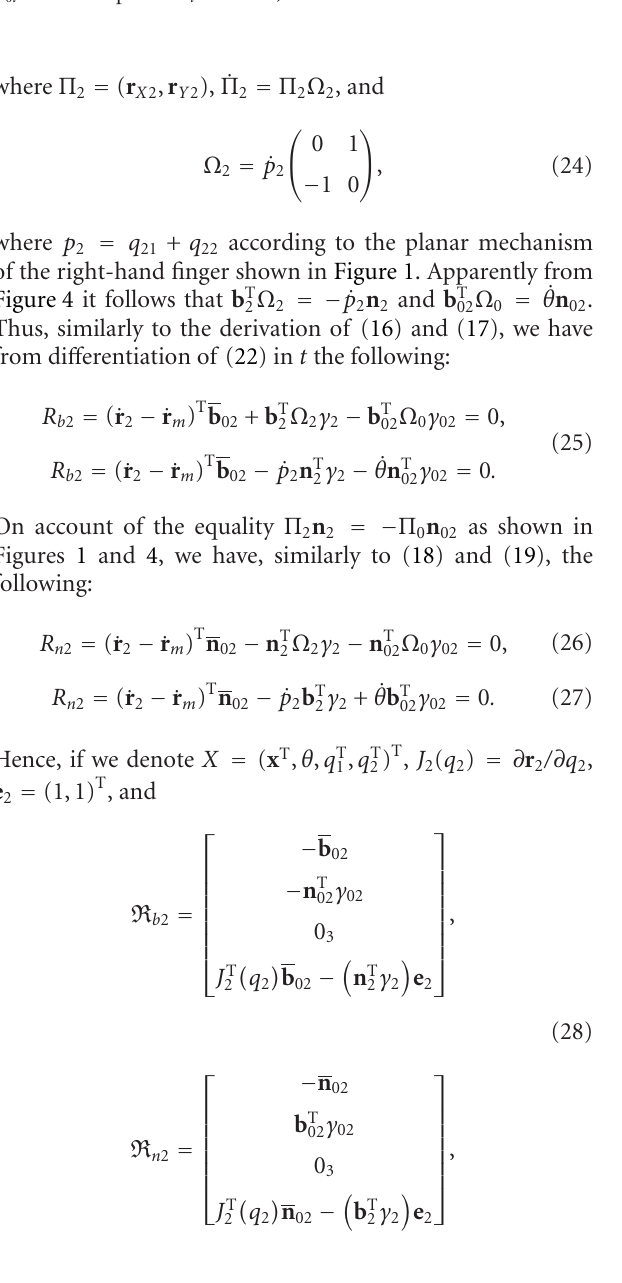
Figure 4: Definitions of tangent vectors b i , b 0 i and normals n i and n 0 i at contact points P i for i = 1,2